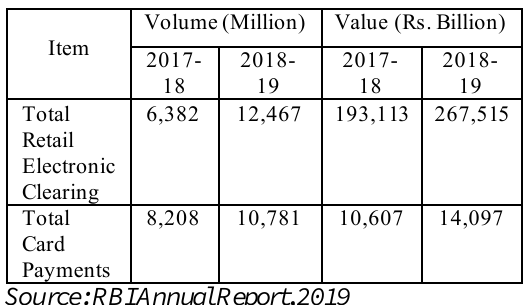
Table. 2. Electronic clearing and Card